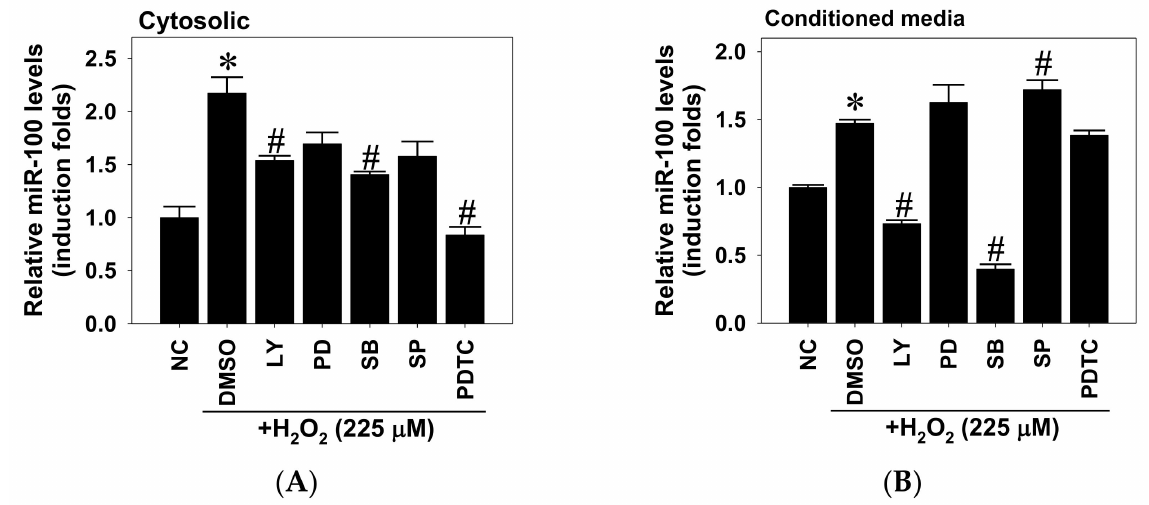
Figure 3. Involvement of hydrogen peroxide-activated signaling in induced miR-100 biosynthesis in human ARPE-19 cells. ARPE-19 cells were pretreated with kinase-specific inhibitors for 1 h, including the PI3K inhibitor LY294002 (LY, 10 µ M), MEK1 inhibitor PD98059 (PD, 10 µ M), p38 inhibitor SB203580 (SB, 20 µ M), JNK inhibitor SP600125 (SP, 20 µ M), NF- κ B inhibitor pyrrolidine dithiocarbamate (PDTC, 50 µ M), or equivalent dimethyl sulfoxide (DMSO) as solvent control, followed by H 2 O 2 exposure at 225 µ M. After 24 h of treatment, lysates ( A ) and conditioned media ( B ) were subjected to miRNA isolation and subsequent RT-qPCR detection for miRNA-100 levels. Semi-quantitative mRNA levels are shown as an induction fold of negative control (NC) in mean ± SD from three independent experiments. * p < 0.05 vs. NC group; # p < 0.05 vs. DMSO groups by